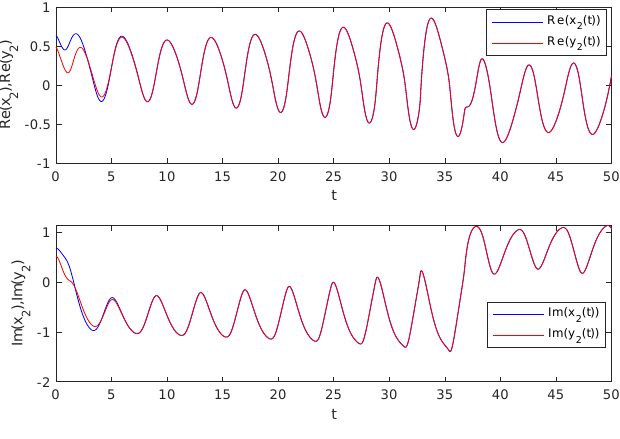
Figure 12. Synchronization between x 1 ( t ) and y 1 ( t ) under the adaptive controller (23).